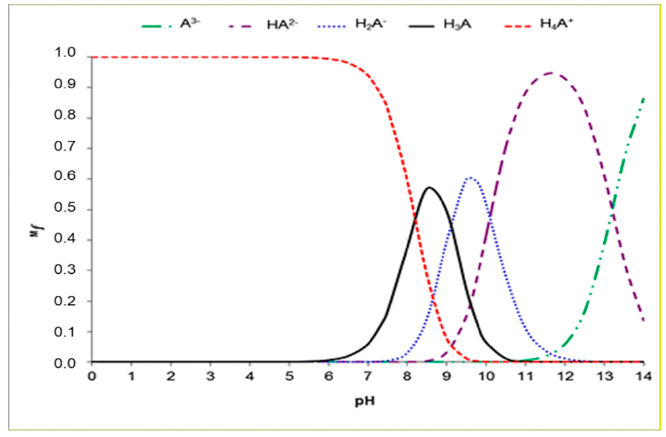
Figure 2. Distribution diagram of higenamine as a function of pH. Table 1. Molar fractions (M f ) of the di ff erent acid–base species of higenamine at physiological pH. H 4 A